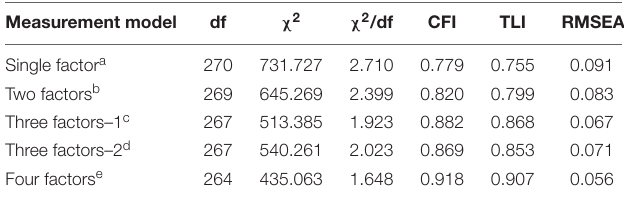
TABLE 2 | Fit indices of the alternative measurement models.